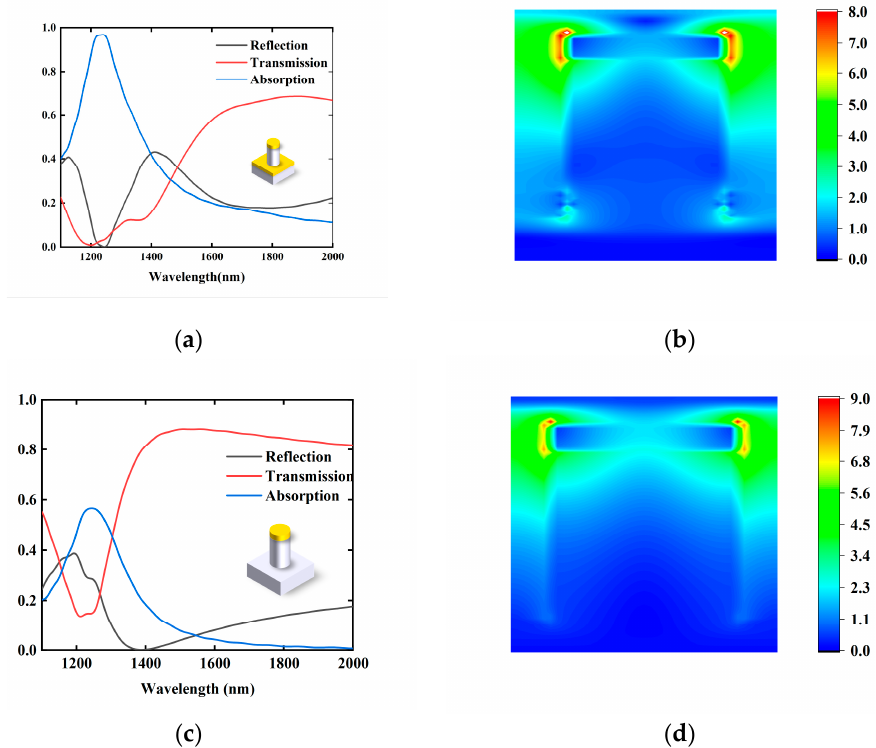
Figure 2. ( a ) Simulated optical reflection, transmission, and absorption for Au/Si NP arrays/Au. ( b ) Simulated electric field distribution in the structure of ( a ). ( c ) Simulated optical reflection, transmission, and absorption for Au/Si NP arrays. ( d ) Simulated electric field distribution in the structure of ( c ).